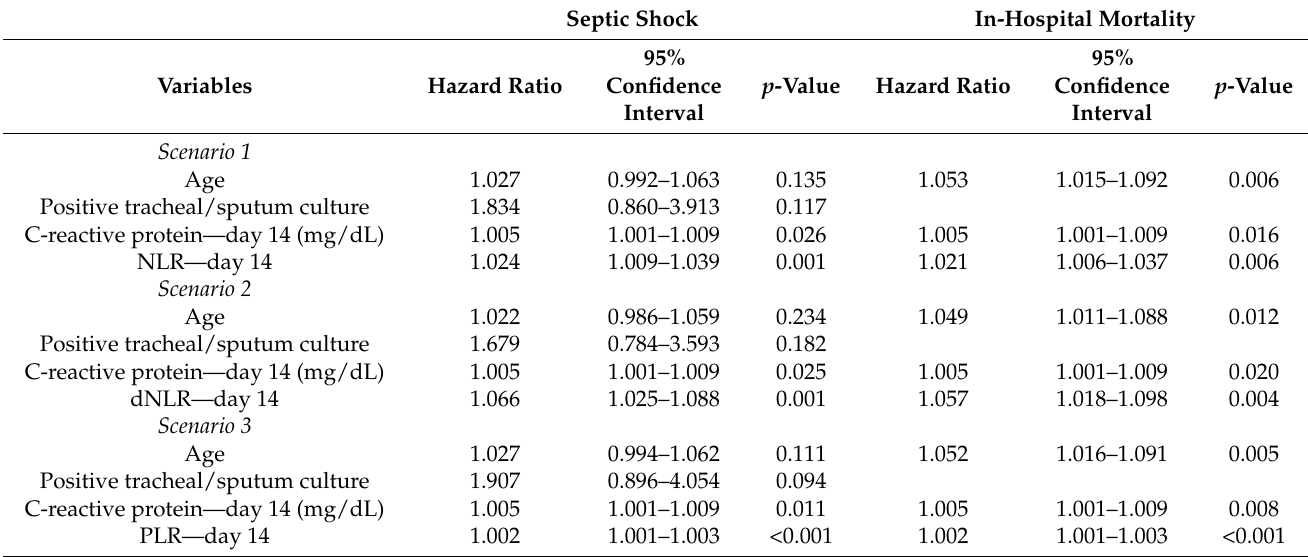
Table 3. Multivariate analysis using Cox-proportional hazards model for the risk of septic shock and in-hospital mortality.